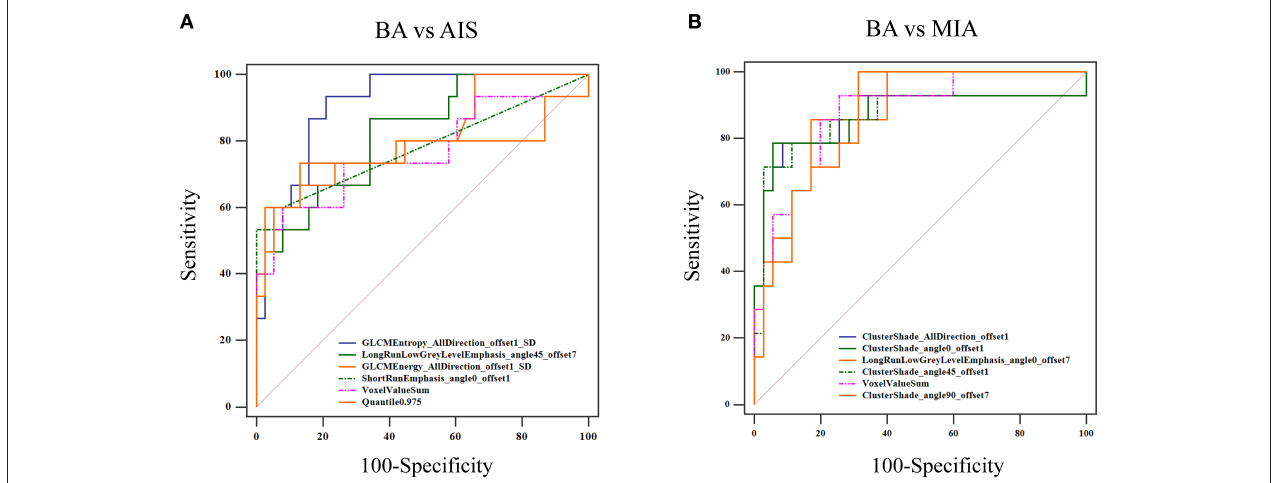
FIGURE 5 | ROC curve for distinguishing BA from AIS/MIA. (A) For BA vs. AIS, the AUC values of GLCMEntropy_AllDirection_offset1_SD, LongRunLowGrey LevelEmphasis_angle45_offset7, GLCMEnergy_AllDirection_offset1_SD, ShortRunEmphasis_angle0_offset1, VoxelValueSum, and Quantile 0.975 were 0.912, 0.823, 0.813, 0.779, 0.763, and 0.760, respectively. (B) For BA vs. MIA, AUC values of ClusterShade_AllDirection_offset1, ClusterShade_angle0_offset1, LongRunLowGreyLevelEmphasis_angle0_offset7, ClusterShade_angle45_offset1, VoxelValueSum, and ClusterShade_angle90_offset7 were 0.876, 0.876, 0.874, 0.870, 0.865, and 0.857, respectively.